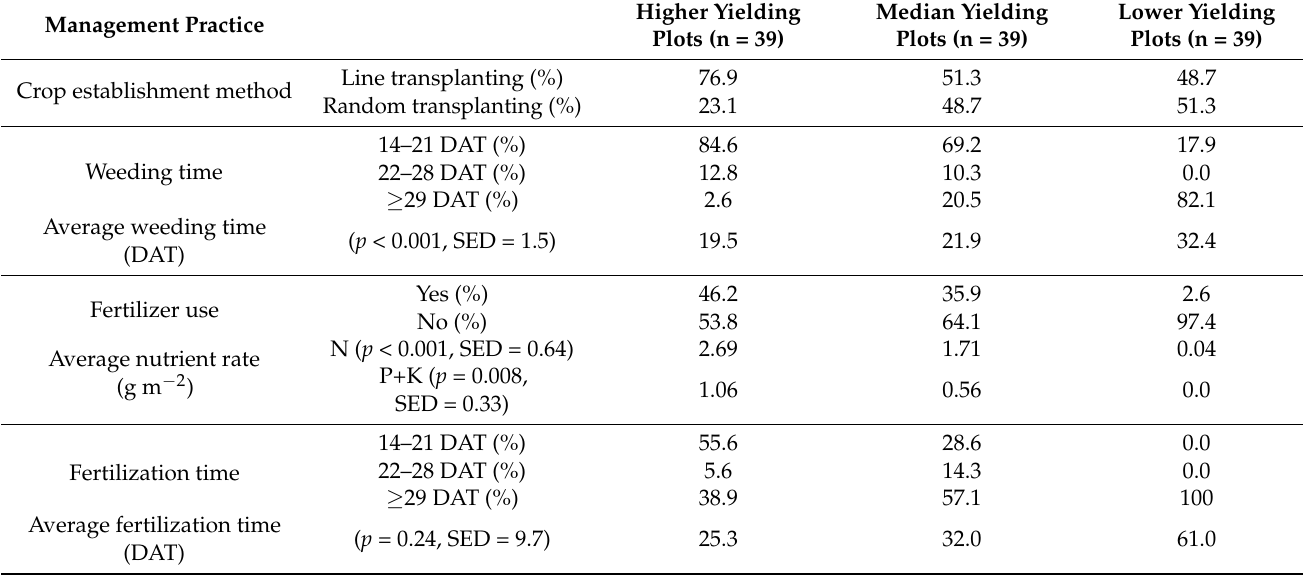
Table 5. Percentage of farmers who applied the different management practices, amount of N, P, and K applied (g m − 2 ), and the number of days after transplanting (DAT) when management was applied in higher, median, and lower yielding plots on farmers’ fields, Doho 2019. n refers to the number of plots, across all treatment plots, with yields that corresponded to the top and lower 10-percentile, and median